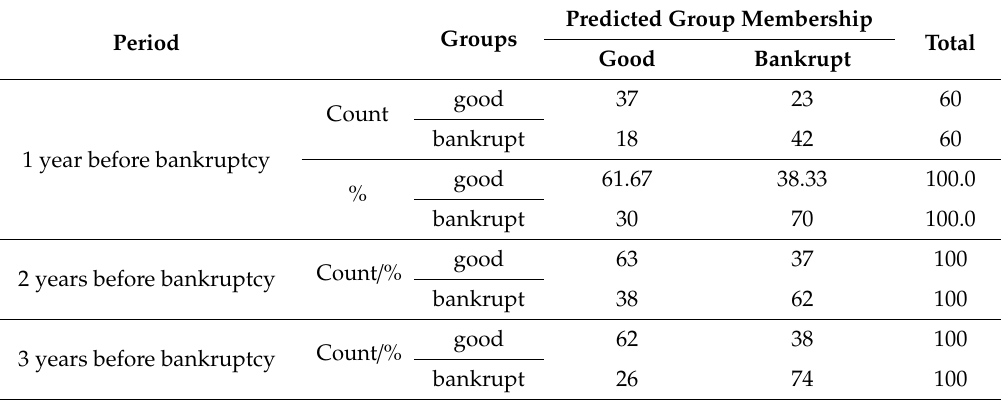
Table 7. Classification results from logit.